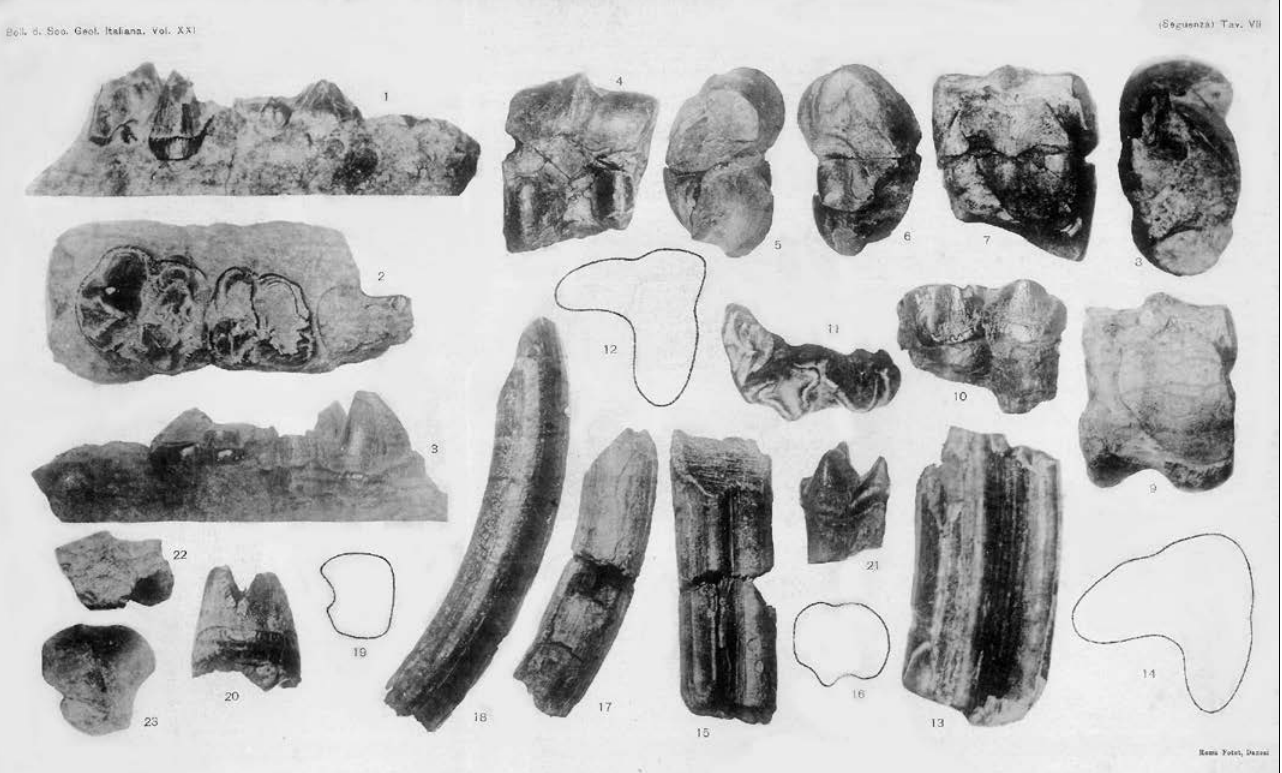
Fig. 3. Late Miocene hippopotamid Hexaprotodon ? siculus (Hooijer, 1946) from Sicily, Italy; original plate from Seguenza (1902: pl. 7). Maxillary frag- ment with DP3, DP4, and M1 from San Pier Niceto, in lingual (1), occlusal (2), and labial (3) views. Fragment of a upper deciduous? tooth from San Pier Niceto (20), two left astragali one from Gravitelli and one from Scirpi (4, anterior view; 5 and 8, medial view; 6, lateral view; 7 and 9, posterior view), partial left M from Gravitelli (10, labial view; 11, occlusal view), C section from Gravitelli (12, view of the transverse section), C and its section from Gravitelli (13, labial view; 14, view of the transverse section), unciform from Gravitelli (22, lateral? view; 23, anterior view). Fig. 4. Late Miocene hippopotamid Hexaprotodon ? siculus (Hooijer, 1946) from Gravitelli, Sicily, Italy; original plate from Seguenza (1907: pl. 6). Mandible fragment with M1, in labial (1), occlusal (2), and lingual (3) views, cervical vertebra in ventral (4), caudal (5), and cranial (6) views, left M3 (7, labial view; 8, occlusal view), right M1–M2 (9, labial view; 10, occlusal view), C fragment (11, labial? view), right dp3 (14, labial view; 15, occlusal view), left dp3 (16, lingual view), P2 (17, lingual view; 18, occlusal view), dp (19, lingual view; 20, occlusal view).